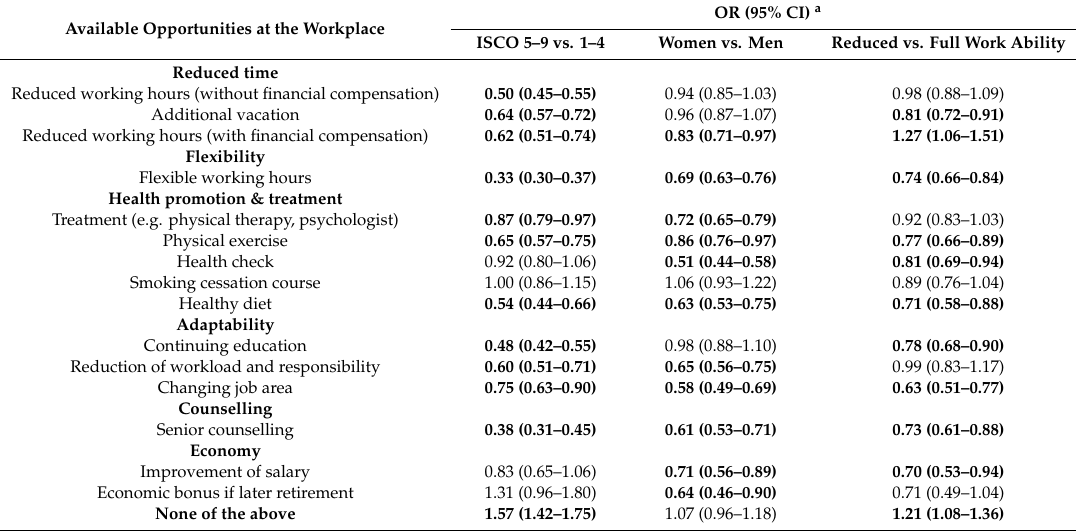
Table 3. Odds ratios and 95% confidence intervals for the availability of di ff erent opportunities at the workplace in ISCO 5–9 vs. 1–4, among women vs. men, and among those with reduced work ability vs. those with full work ability. Values less than 1 mean that there is less of a chance of having that opportunity at the workplace. Statistically significant findings are marked in bold. OR (95% CI) a Available Opportunities at the Workplace ISCO 5–9 vs. 1–4 Women vs. Men Reduced vs. Full Work Ability 0.50